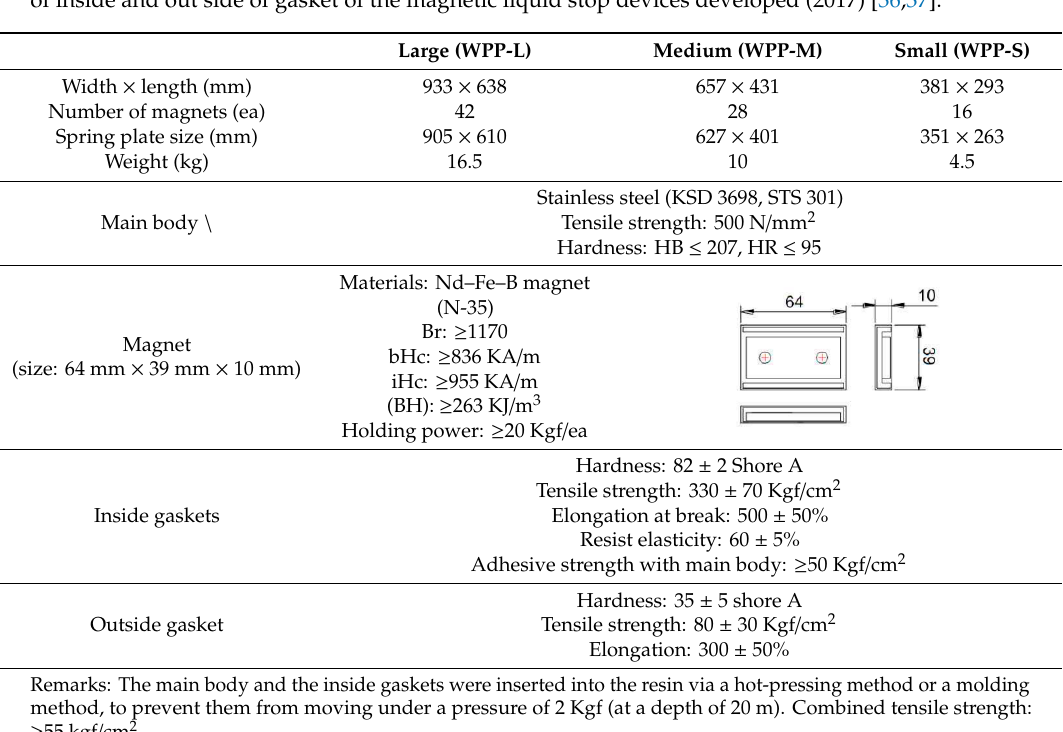
Table 1. Specifications of size, material of main body((cold rolled stainless steel plates, KSD), (stainless steel, STS), (Brinell Hardness, HB), (Rockwell Hardness, HR)), magnet type and size(Neodymium, (magnetic flux density, Br), (coercive force, bHc), (intrinsic coercive force, iHc), (max energy, BH)), type of inside and out side of gasket of the magnetic liquid stop devices developed